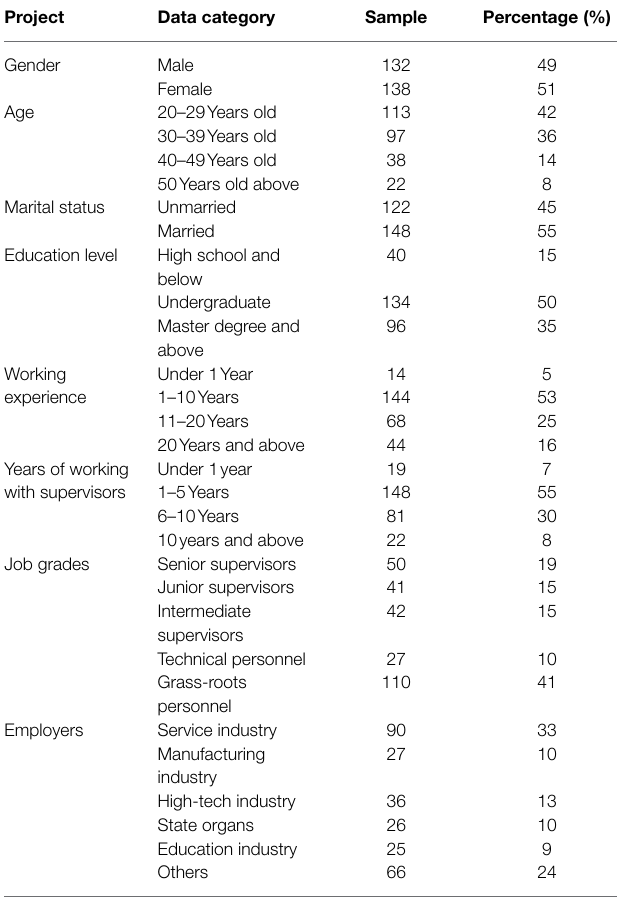
TABLE 1 | Summary of sample characteristics.